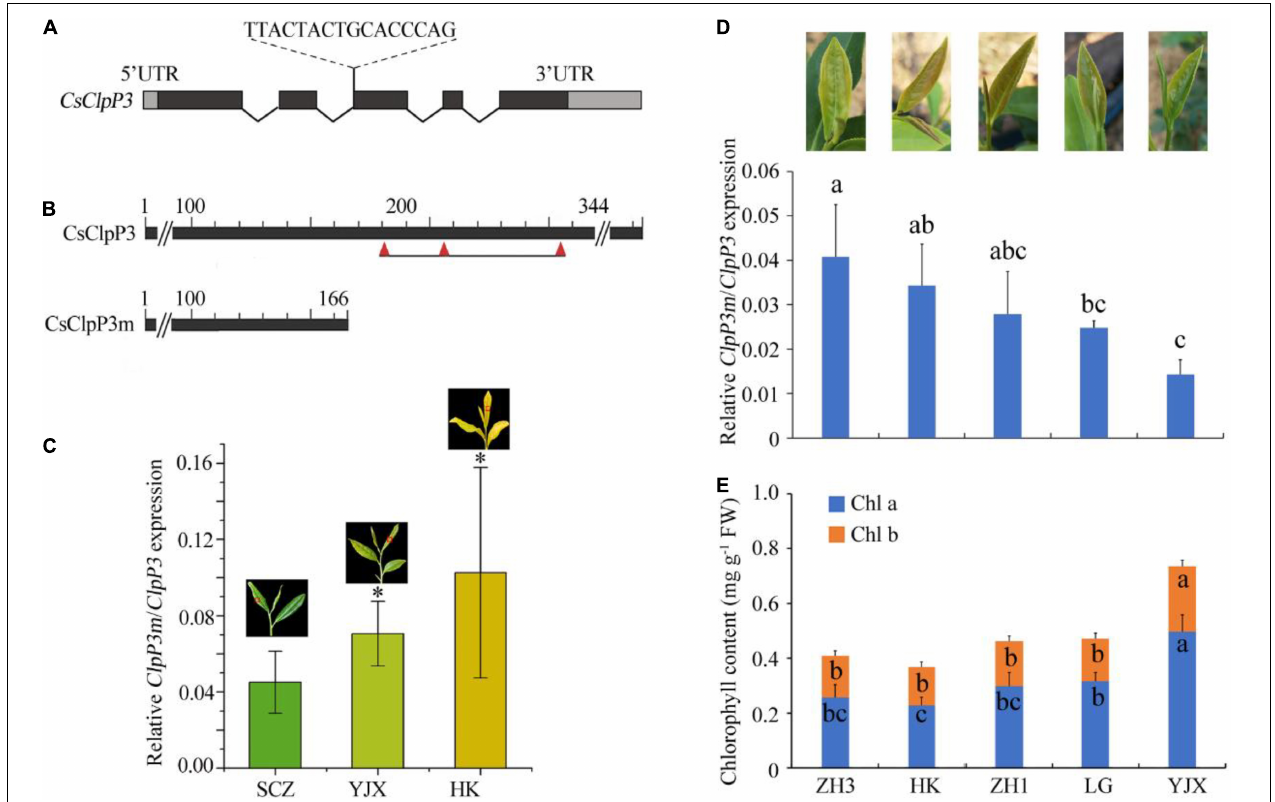
FIGURE 2 | Gene structure of CsClpP3 and its intron retention variant CsClpP3m and their transcript levels in tea leaves. (A) The intron retention site and fragment of CsClpP3 . (B) Prediction of active sites for deduced ClpP3 and ClpP3m. Three red triangles refer to the Ser-His-Asp residues that form the ClpP3 catalytic triad. (C) Relative transcript levels of ClpP3m to these of ClpP3 in three tea cultivars with different chlorotic leaf phenotypes in early spring. Red squares on the leaves mark the chosen colors for the corresponding columns. (D) Transcript level ratio of ClpP3m to ClpP3 in cultivars ZH3, HK, ZH1, LG, and YJX in summer. (E) Chlorophyll contents in cultivars ZH3, HK, ZH1, LG, and YJX. SCZ, ‘Shu-Cha-Zao’; YJX, ‘Yu-Jin-Xiang’; HK, ‘Huang-Kui’; ZH1, ‘Zhong-Huang1’; ZH3, ‘Zhong-Huang3’; LG, ‘Le-Guan.’ One way-ANOVA analysis was performed using SPSS19 software. “ ∗ ” or different letters denote p <